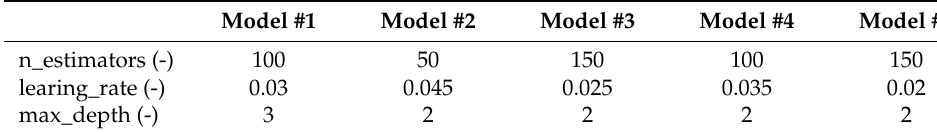
Table 3. Optimized GBRT parameters of five models.